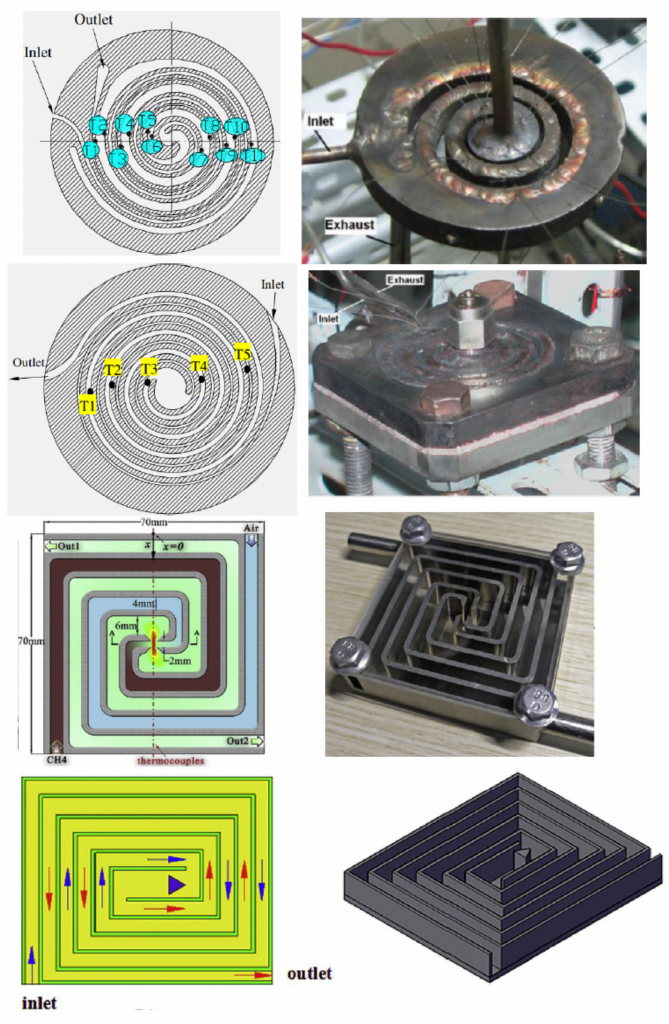
Figure 23. Four types of Swiss-roll combustors were used in the